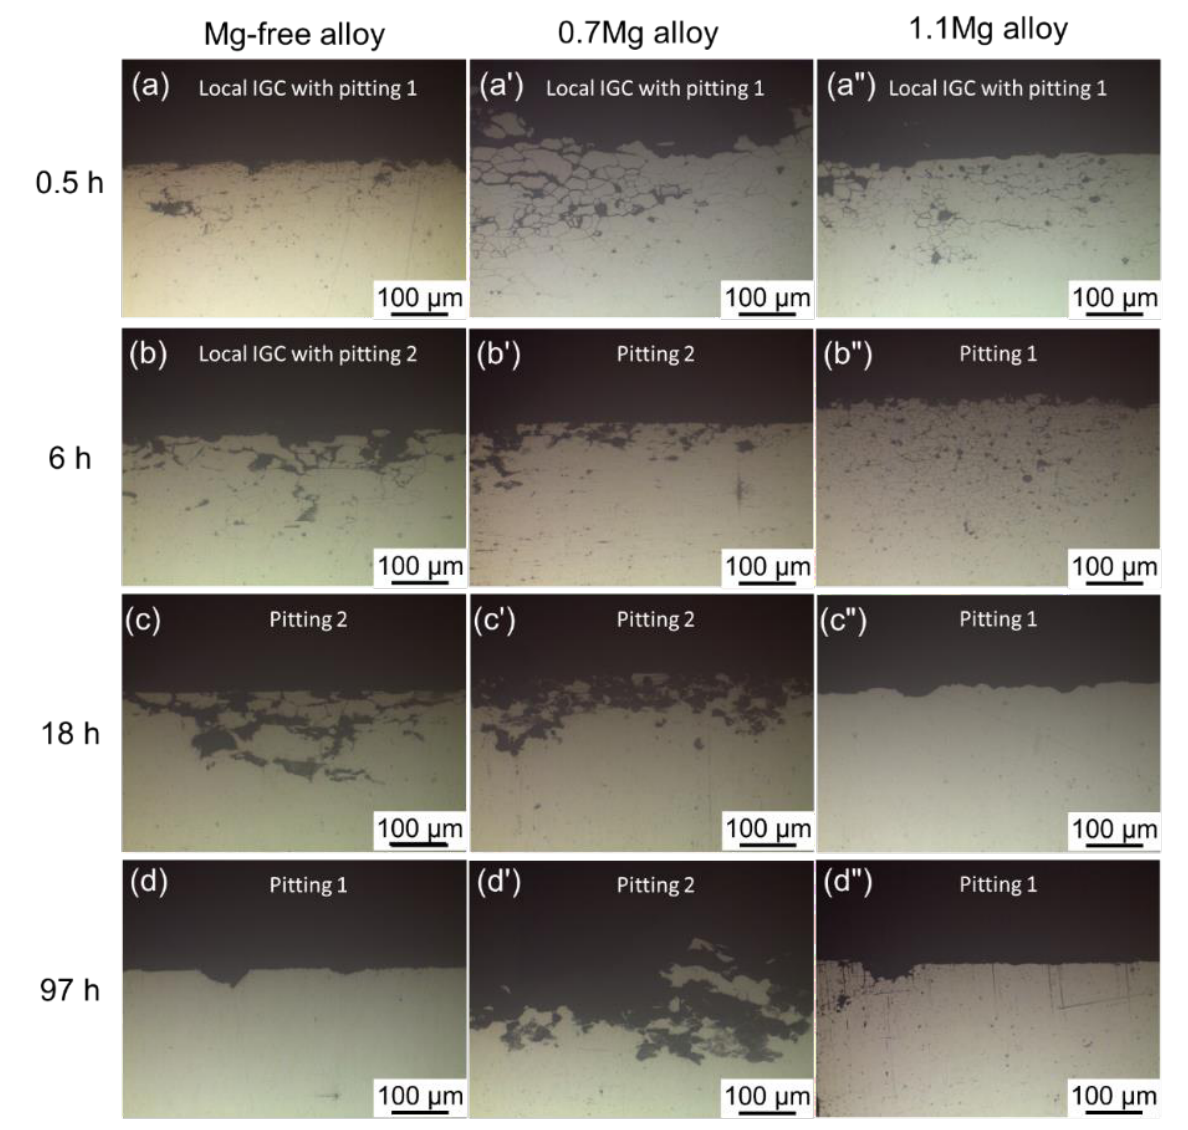
Figure 5. Cross-sectional micrographs of Mg-free alloy aging at 150 °C for ( a ) 0.5 h, ( b ) 6 h, ( c ) 18 h, ( d ) 97 h; 0.7Mg alloy aging at 150 ◦ C for ( a’ ) 0.5 h, ( b’ ) 6 h, ( c’ ) 18 h, ( d’ ) 97 h; 1.1Mg alloy aging at 150 ◦ C for ( a” ) 0.5 h, ( b” ) 6 h, ( c” ) 18 h, ( d” ) 97 Table 3. Corrosion mode, maximum and average depth of investigated alloys aged for different times.